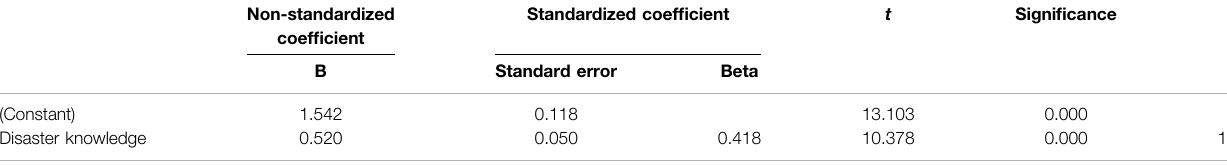
TABLE 5 | Analysis of the impact of disaster knowledge perception on tourists ’ behavioral intentions.